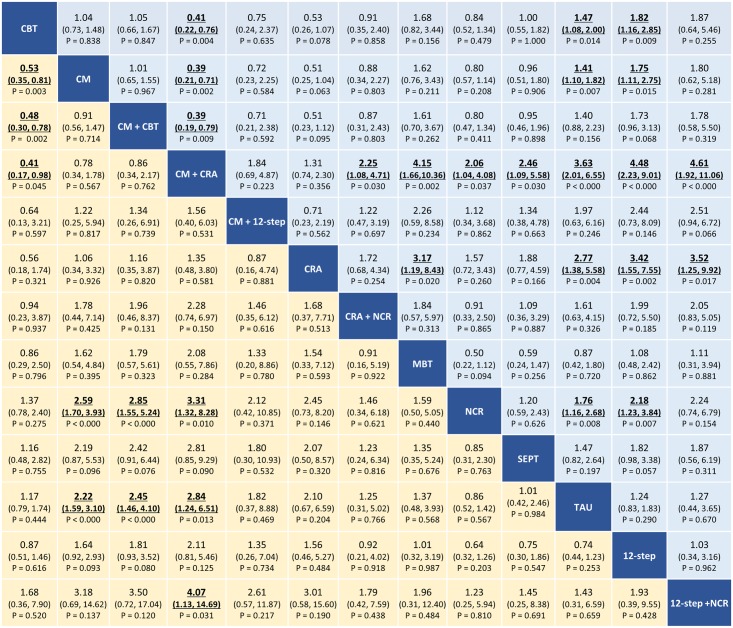
Network meta-analysis of efficacy (yellow) and acceptability (blue) at the end of treatment.Psychosocial treatments are reported in alphabetical order. Comparisons should be read from left to right. Abstinence and dropout estimates are located at the intersection between the column-defining and the row-defining treatment. For abstinence, ORs above 1 favour the column-defining treatment. For dropout, ORs above 1 favour the row-defining treatment. To obtain ORs for comparisons in the opposite direction, reciprocals should be taken. Significant results are in bold and underlined. CBT, cognitive behavioural therapy; CM, contingency management; CRA, community reinforcement approach; MBT, meditation-based therapies; NCR, non-contingent rewards; OR, odds ratio; SEPT, supportive-expressive psychodynamic therapy; TAU, treatment as usual; 12-step, 12-step programme.